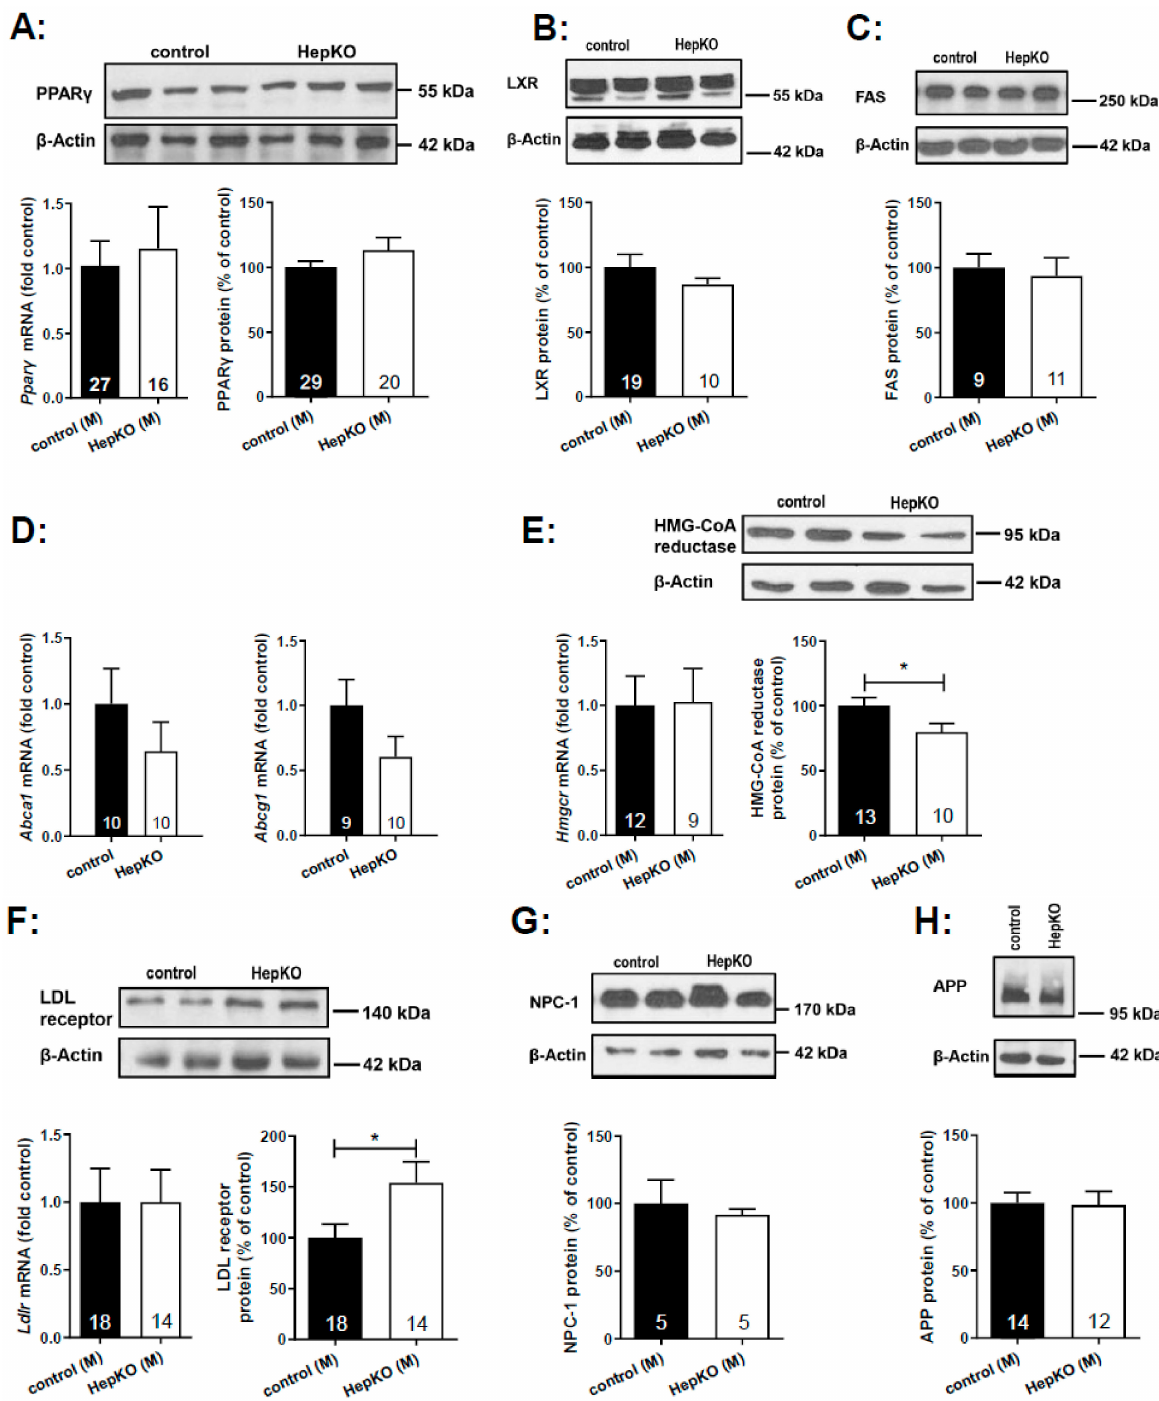
Figure 6. Expression of genes and proteins involved in lipid metabolism in liver of Sgpl1 HepKO mice. Expression of mRNA and protein levels was analyzed by quantitative real-time PCR and Western blotting, respectively, in liver homogenates of male Sgpl1 control (black bars) and Sgpl1 HepKO mice (white bars) at the age of 8 months. ( A ) PPAR γ ; ( B ) liver X receptor (LXR); ( C ) fatty acid synthase (FAS); ( D ) Abca1 and Abcg1 ; ( E ) HMG-CoA reductase; ( F ) LDL receptor; ( G ) NPC1; ( H ) APP. Shown are representative blots from individual mice, and densitometric quantification of blots of the indicated number of mice. All values are means ± SEM. * p < 0.05 in two-tailed Student’s t